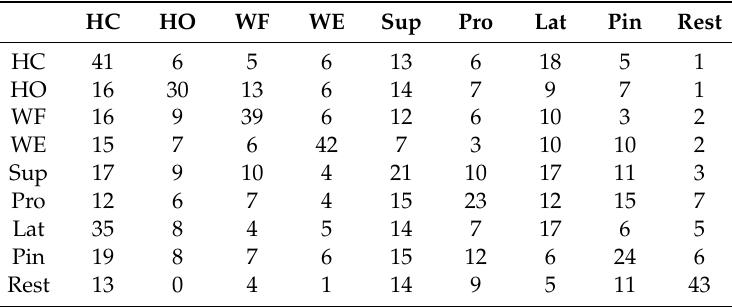
Table 6. Confusion matrix based on between-session calibration (the mean across the two days have been calculated) using linear discriminant analysis. All values are in percent and presented as the mean across participants. HC (Hand Close), HO (Hand Open), WE (Wrist Extension), WF (Wrist Flexion), Sup (Supination), Pro (Pronation), Lat (Lateral Grasp), and Pin (Pinch Grasp).